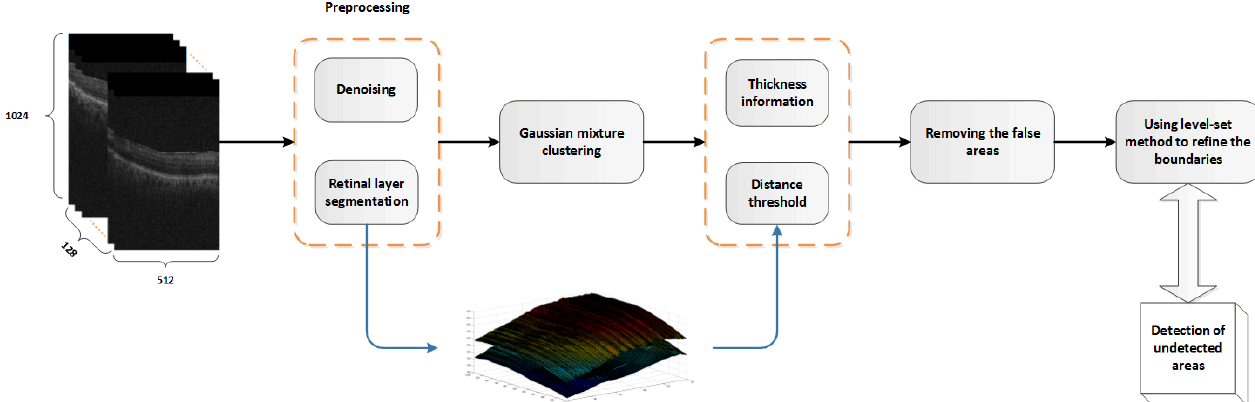
Fig. 1. Overview of the proposed